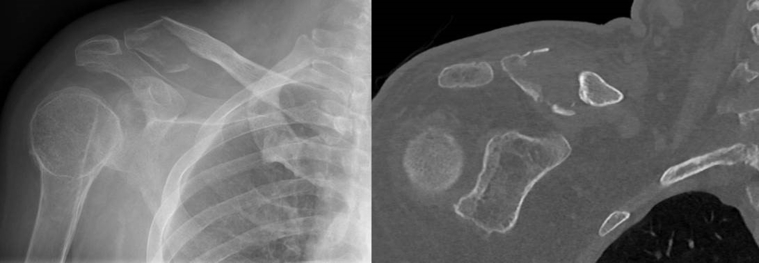
Imaging of comminuted distal clavicle fragment in case 1.